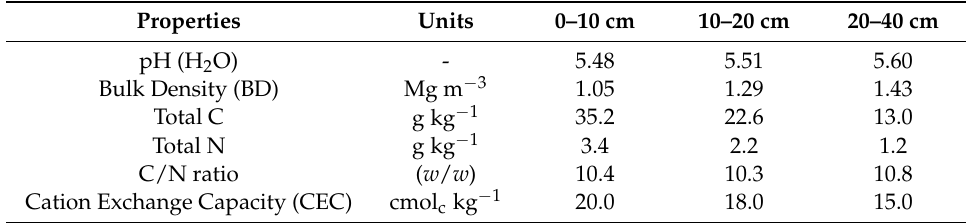
Table 2. Chemical characteristic of Tokomaru silt loam soil (Palmerston North, New Zealand) at the beginning of